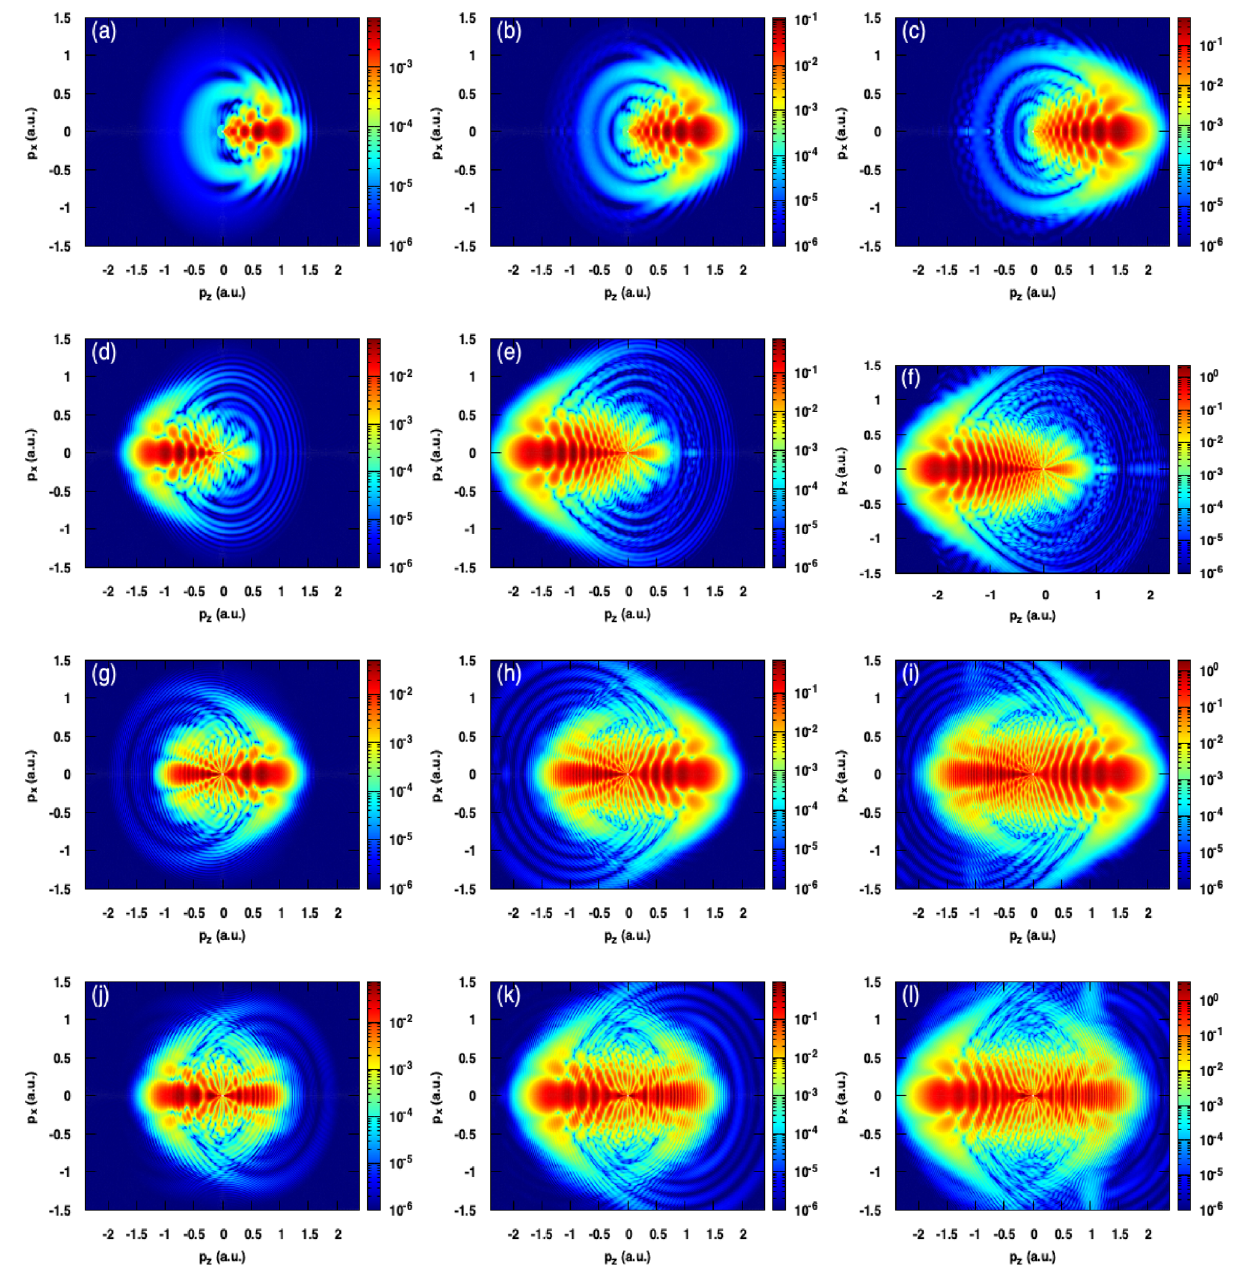
Figure 6. Photoelectron momentum distributions for three different peak intensities for a laser pulse with (cid:31) =800nm . Panels of the first, second and third columns correspond respectively to the peak intensities fixed at 100 TW/cm 2 , 200 TW/cm 2 and 300 TW/cm 2 . ( a , b , c ) N = 1; ( d , e , f ) N = 2; ( g , h , i ) N = 3; ( k , l , m ) N = 4. All the heat maps in this figure were generated using Gnuplot software (www. gnupl ot. info), version [5.4] for Unix